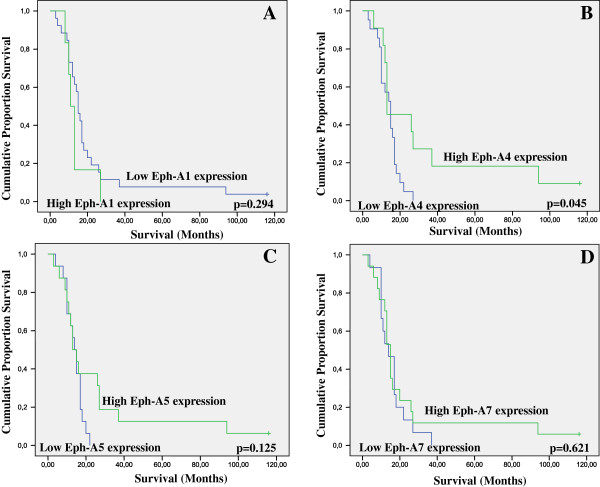
Kaplan-Meier survival analysis stratified according to A. EphA1, B. EphA4, C. EphA5 and D. EphA7 expression in 32 squamous-type NSCLC patients (–complete cases; + censored cases).